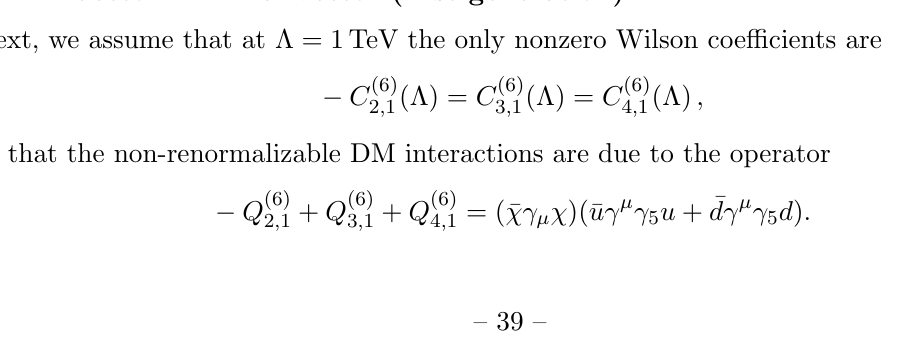
Figure 14 . The inverse scattering rates on Xenon (left) and Fluorine (right) for I Dirac fermion DM with additional dimension-six interactions coupling a DM axial-vector current to the SM axial-vector third generation current, setting (cid:3) = 1 TeV. The red lines show the predicted rates without mixing; the blue lines after RG resummation. The plots extend in m (cid:31) below the electroweak scale only for illustration purposes | realistic models require extended sets of non- trivial electroweak multiplets that can modify the running (cf. section